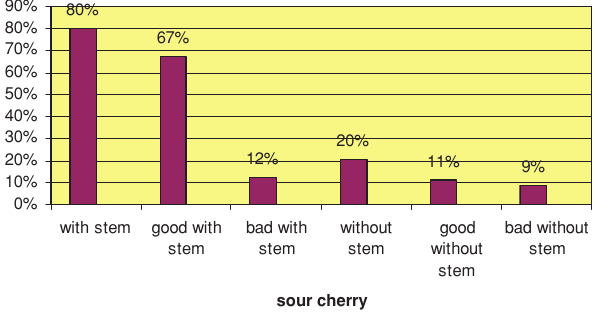
Figure 2. Distribution of the sour cherry offered with stem and without stem, of good and of bad quality in mediocre shops